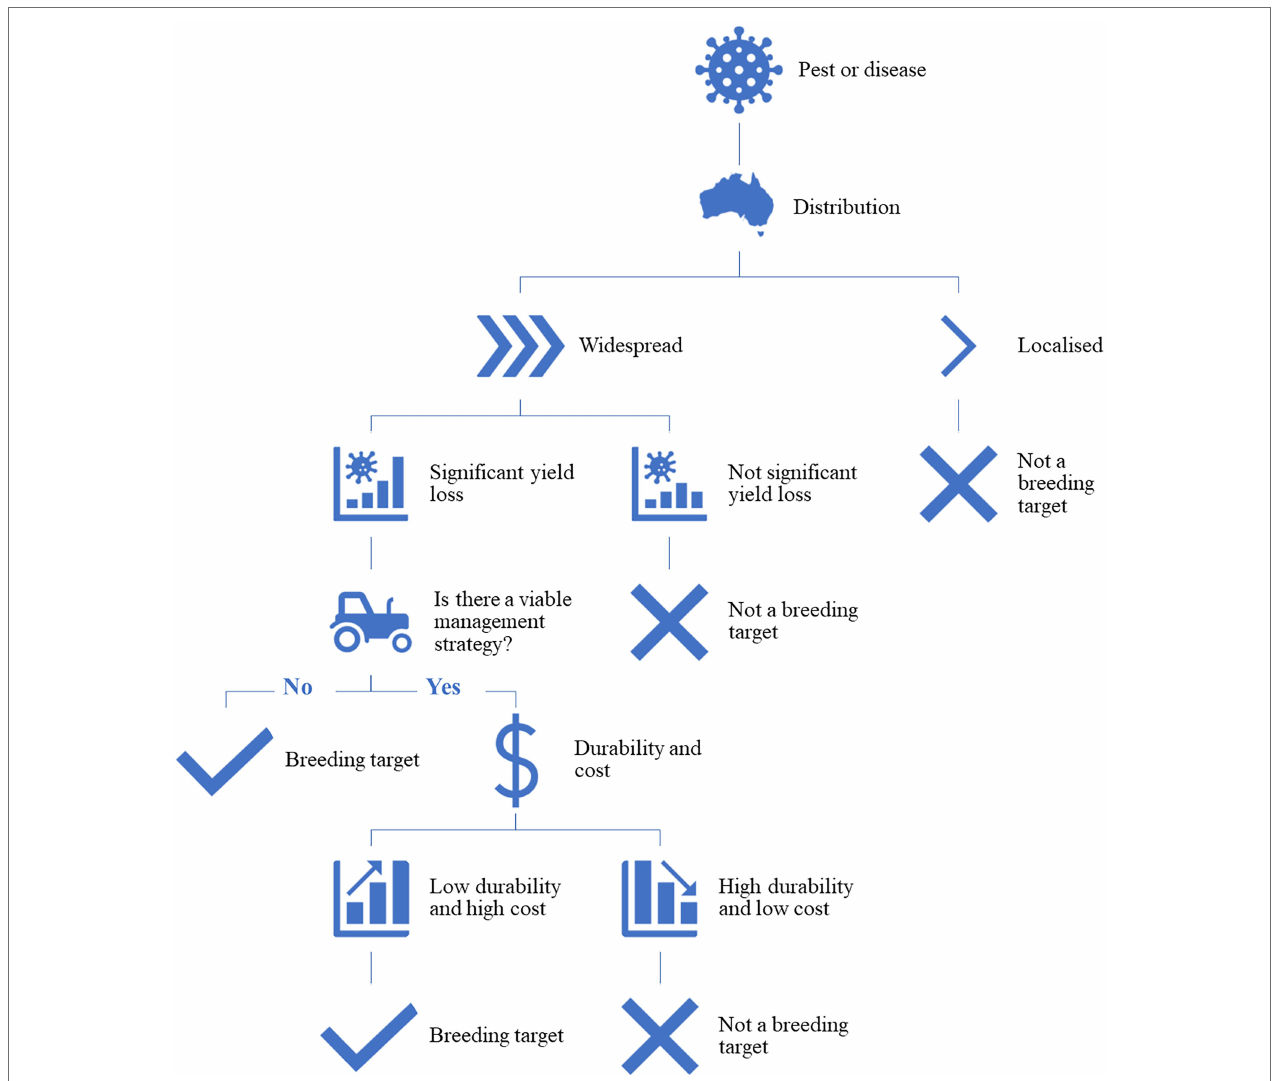
FIGURE 1 | The high-level decision-making process to determine if a breeding program is justified to develop cultivars as a management strategy to control a pest or